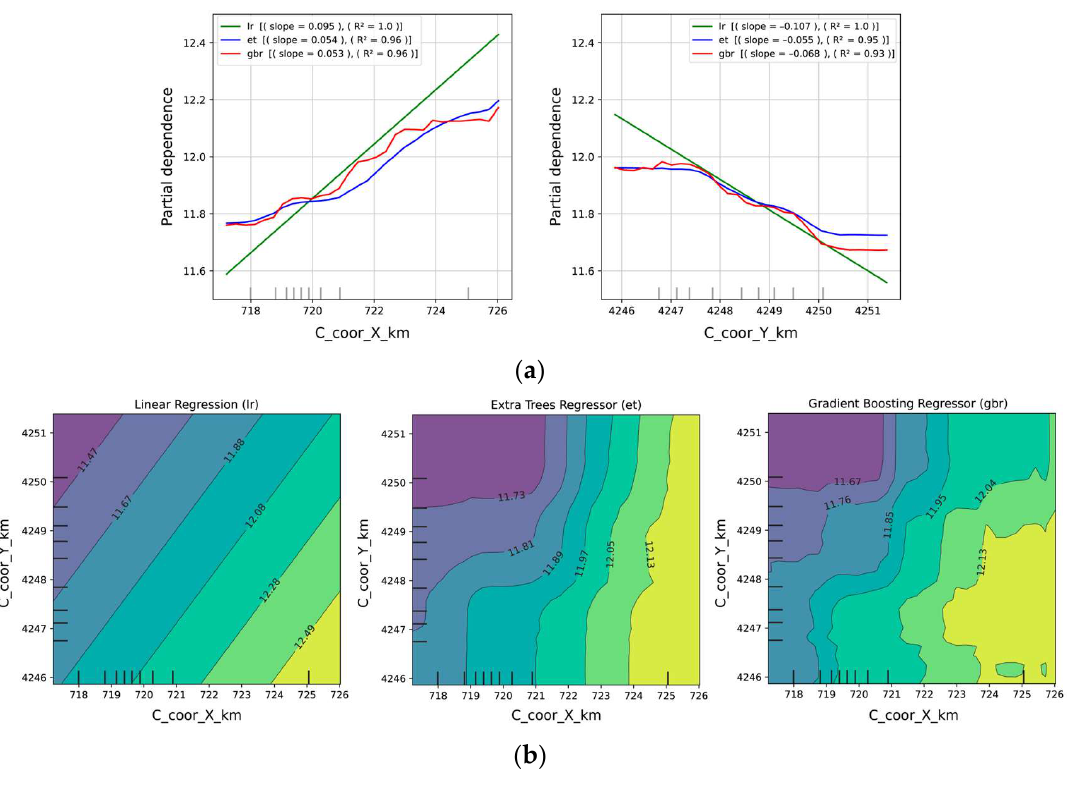
Figure 16. ( a ) One-way partial dependence plots for X and Y coordinates with lr , et , and gbr algo- rithms. ( b ) Two-way directional partial dependence plots for lr , et , and gbr algorithms.